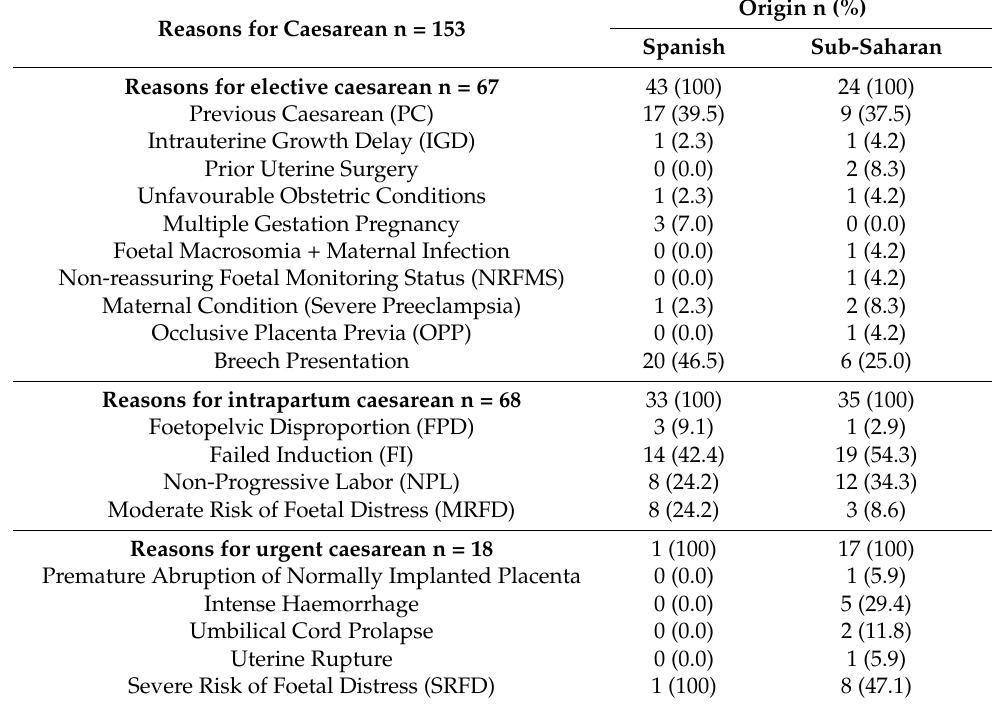
Table 2. Reasons for caesarean according to origin.